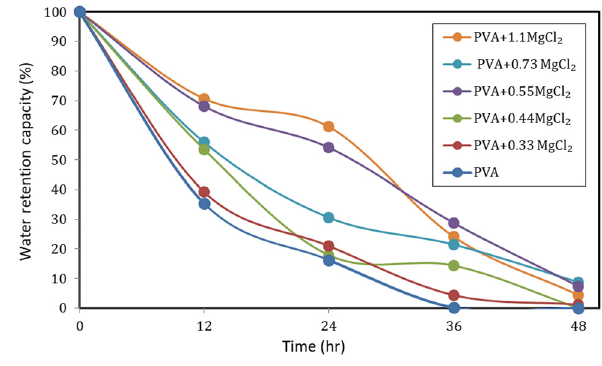
Figure 12: Water retention capacity ( % ) of PVA SAPs at various immersion